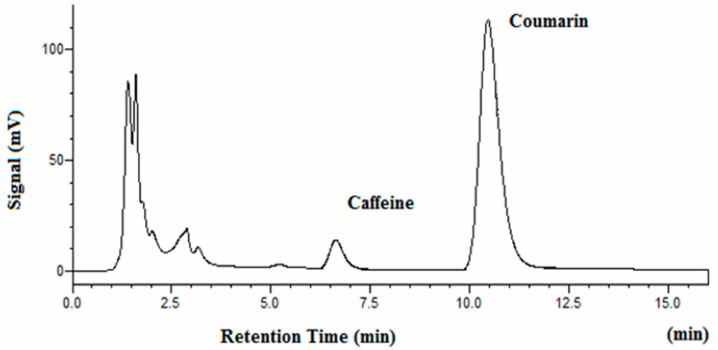
Figure 5. Chromatogram of vanilla beans after subcritical water extraction at 100 ◦ C (internal standard: coumarin).